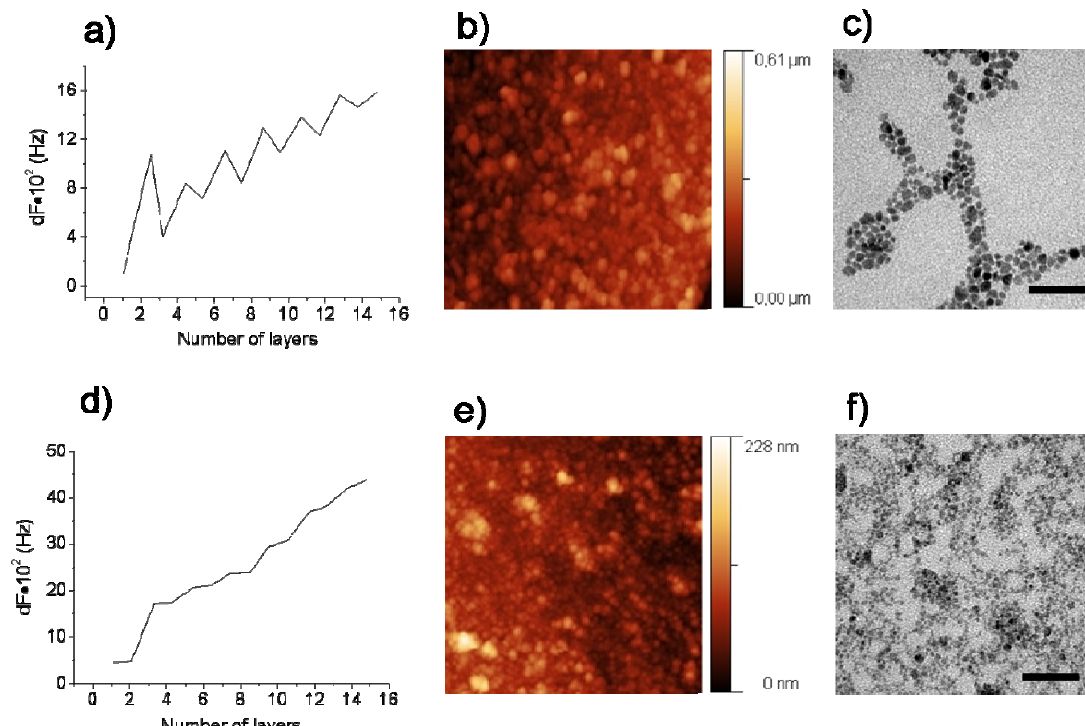
Figure 5. ( a ) QCM measurement during deposition of polyelectrolyte layers and negative magnetic nanoparticles. ( b ) AFM and ( c ) TEM images of magnetite/polyelectrolyte film with negative nanoparticles, respectively. ( d ) QCM measurement during deposition of polyelectrolyte layers and positively charged magnetic nanoparticles. ( e ) AFM and ( f ) TEM images of magnetite/polyelectrolyte film with positively charged nanoparticles, respectively. The area of AFM scans is 5 × 5  m 2 , the scale bars in the TEM